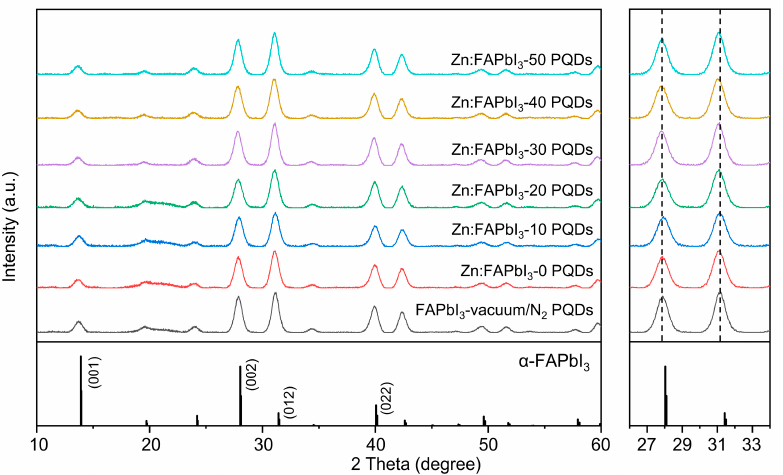
Figure 3. XRD patterns of the FAPbI 3 -vaccum/N 2 , Zn:FAPbI 3 -0, Zn:FAPbI 3 -10, Zn:FAPbI 3 -20, Zn:FAPbI 3 -30, Zn:FAPbI 3 -40, and Zn:FAPbI 3 -50 PQDs. The right panel presents the enlarged XRD patterns in the range of 26 to 34 degrees.